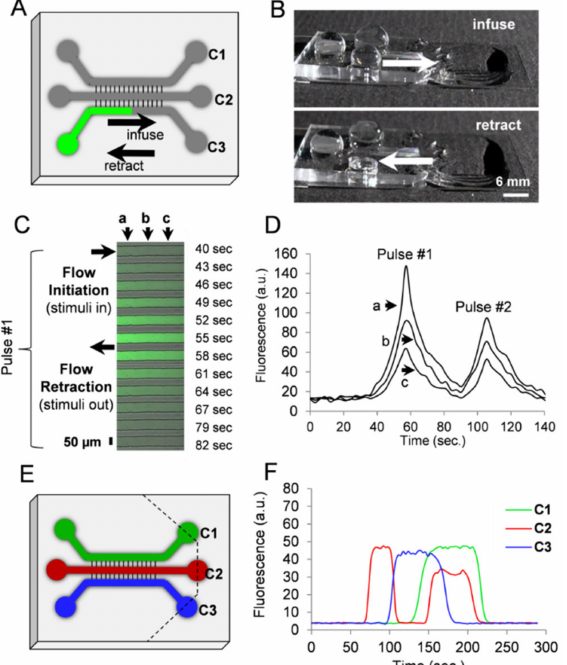
Figure 6. Chemotemporal pulses in microfluidic channels. ( A ) Schematic and image of PDMS chan- nels on a coverslip for a fluidically connected microfluidic platform for cell signaling. ( B ) Using surface tension and gravity flow, chemicals can be pulsed in the channel for stimulating compart- mentalized cells. ( C ) For pulse characterization, dilute FITC-conjugated secondary antibodies (green) were introduced in the channel. Spatial characteristics were assessed at three separate points 125 µ m apart (a, b, c). Data for panel ( C ) was acquired from the midpoint of channel C3 as shown in the schematic of panel A. ( D ) Two serial pulses demonstrate spatiotemporal characteristics for multiple cellular stimulations. In pulse #1, half-maximal stimulation concentration is achieved at peak (a) with a concentration decay of 40% at peak (b) and 57% at peak (c). Positions of points a, b, c as in ( C ). ( E ) Parallel pulsatile flow actuated by surface tension and gravity-mediated passive pumping within the same device. The device was cut along the dashed lines to allow for unrestricted outflow. Pulsatile flow was accomplished as shown in ( B ) with an increased fluid head at the inlet initiating channel infusion and the emptying of the inlet, resulting in flow retraction. ( F ) Flow in the three individual channels (C1, C2, C3) can be modulated independently to produce spatiotemporal pulses as depicted in the profiles of fluorescence. Flow was initiated in C2, then retracted in C2 at the same time as C3 initiation; infusion of C1 and re-infusion of C2 precede retraction at C3, ending with serial retractions from C2 and